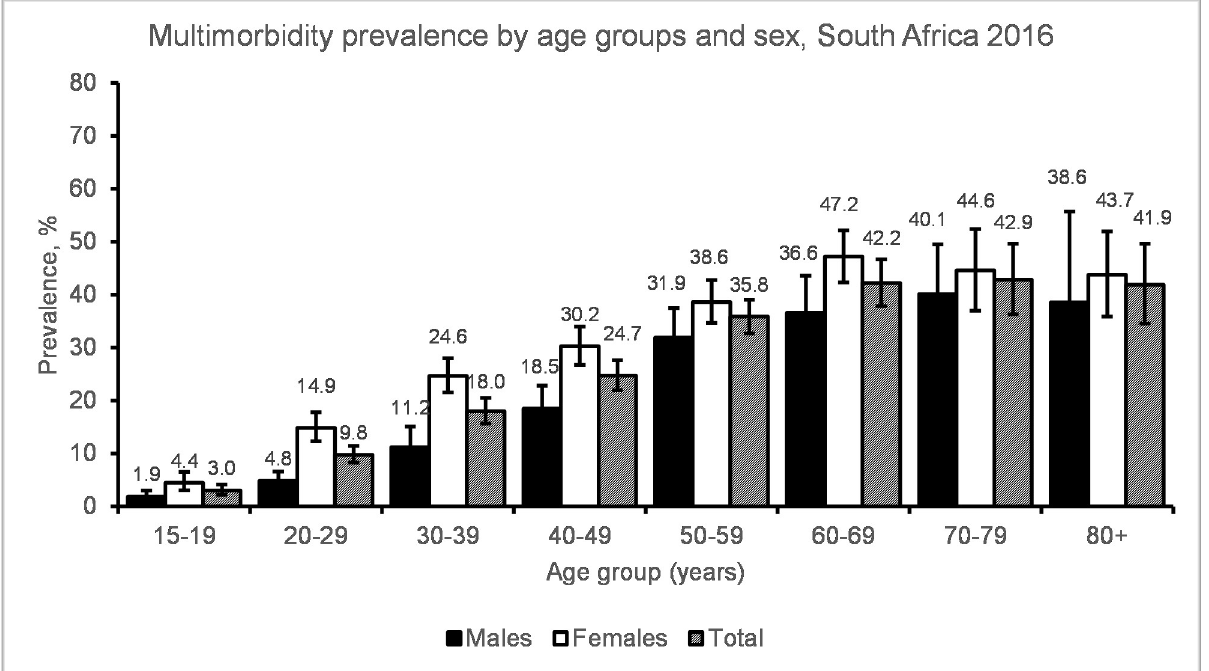
Fig 1. Estimated multimorbidity prevalence by age group and sex in South Africa in 2016.